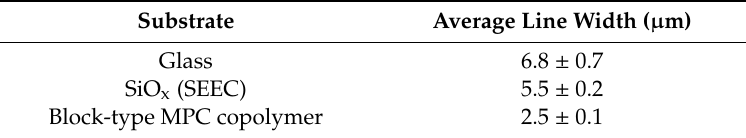
Table 2. Average line width of lipid lines on the di ff erent substrates.